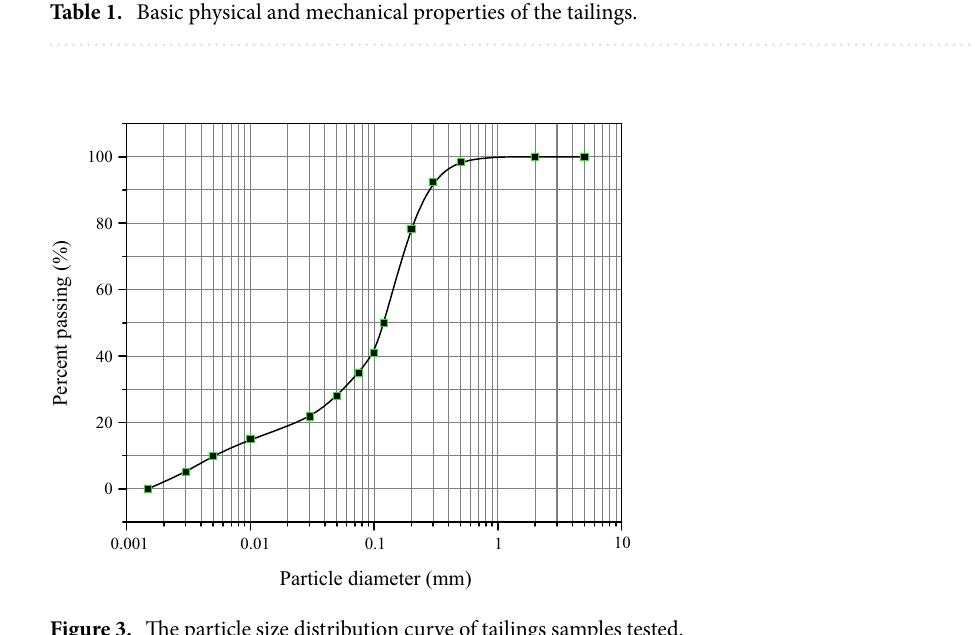
Table 1. Basic physical and mechanical properties of the tailings.